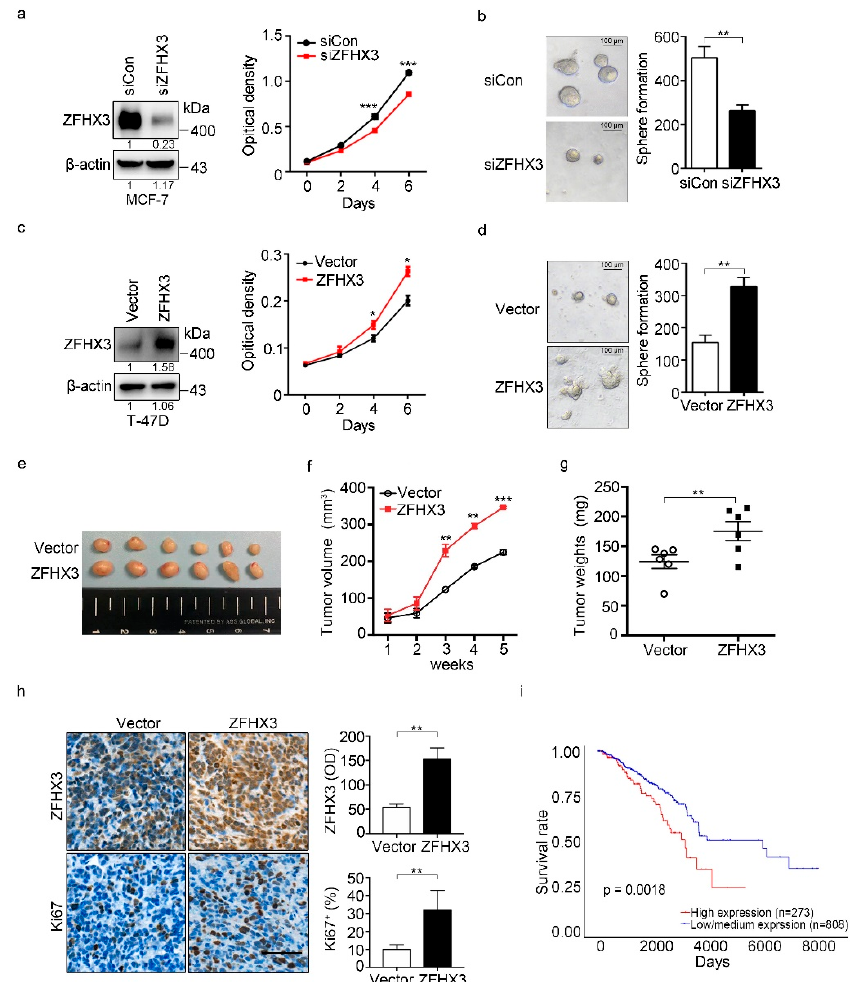
Figure 1. ZFHX3 enhances colony formation and tumorigenicity of ER + breast cancer cells. ( a , b ) ZFHX3 silencing by RNAi inhibited colony formation in 2D culture ( a ), as determined by the sulforhodamine B (SRB) assay, and sphere formation in Matrigel ( b ), as indicated by representative images of spheres (left) and the numbers of spheres with a diameter >75 µm (right) in MCF-7 cells. siCon, control siRNA; siZFHX3, siRNA against ZFHX3 . ( c , d ) Ectopic expression of ZFHX3 promoted colony formation in the 2D SRB assay ( c ) and 3D sphere formation in Matrigel ( d ) in T-47D cells. ( e – g ) ZFHX3 expression in T-47D cells also promoted their subcutaneous tumor formation in nude mice, as indicated by tumor images ( e ), tumor growth curve ( f ), and tumor weight ( g ). ( h ) Enhanced tumor growth by ZFHX3 was accompanied by increased cell proliferation, as indicated by representative images of IHC staining of ZFHX3 , Ki67 in xenograft tumors, and the quantification of ZFHX3-positive cells (up) , Ki67-positive cells (down). Scale bar, 50 µm. ( i ) Higher mRNA levels of ZFHX3 are associated with worse survival in patients with breast cancer in the TCGA database, as analyzed by survival analysis. * p < 0.05; ** p < 0.01; *** p < 0.001. Ratios of protein band intensities to those of their loading controls, with the control sample’s normalized to 1, are shown under bands in western blots ( a , c ). Uncropped western blot images are available in Supplementary Figure S7.